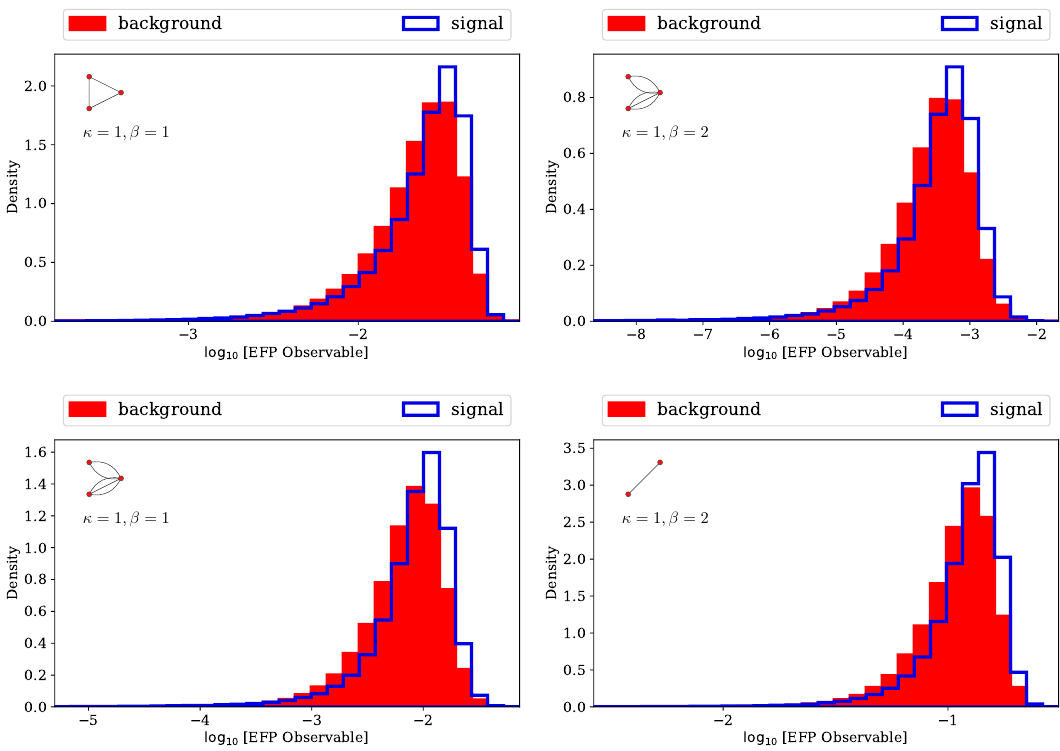
Figure 5. Distributions of the log of the selected IRC-safe EFPs as chosen by the black-box 10 guided strategy, for prompt (signal) muons and non-prompt (background)